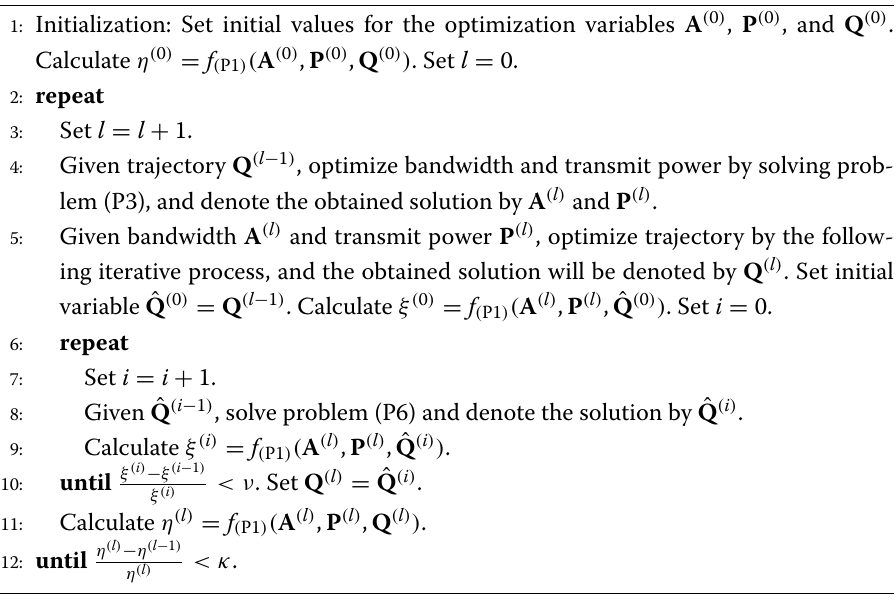
Algorithm 1 Proposed Algorithm to Solve Problem